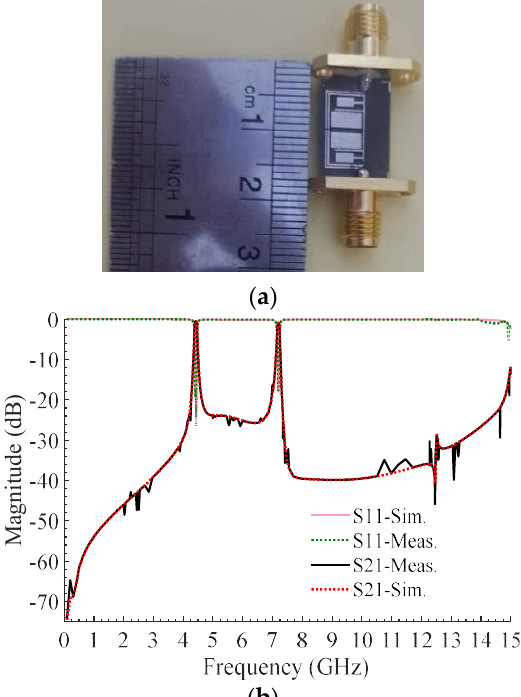
Figure 13. Proposed BPF: ( a ) A photo of the fabricated filter: ( b ) Simulation and measurement results.